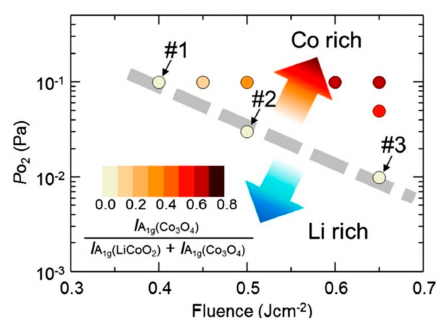
Figure 2. The relationship between impurity inclusions and growth conditions of PLD-grown LCO films established from spectroscopic Raman data (Reproduced with permission from [51]. Copyright 2017 AIP